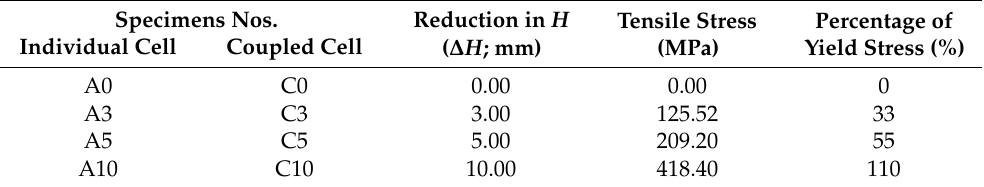
Table 2. Chemical compositions of the C-shape carbon steel specimen.